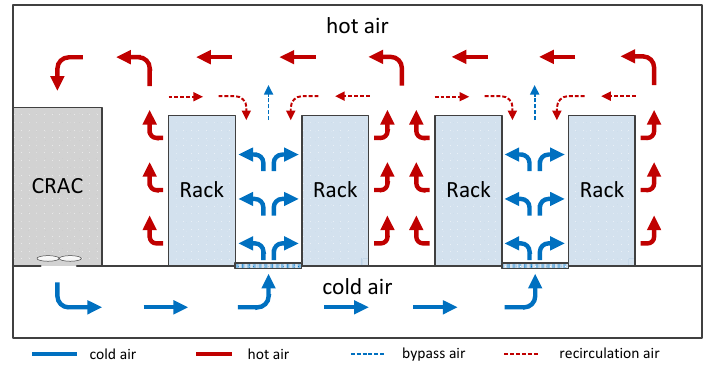
Figure 1. Typical air cooling system in data